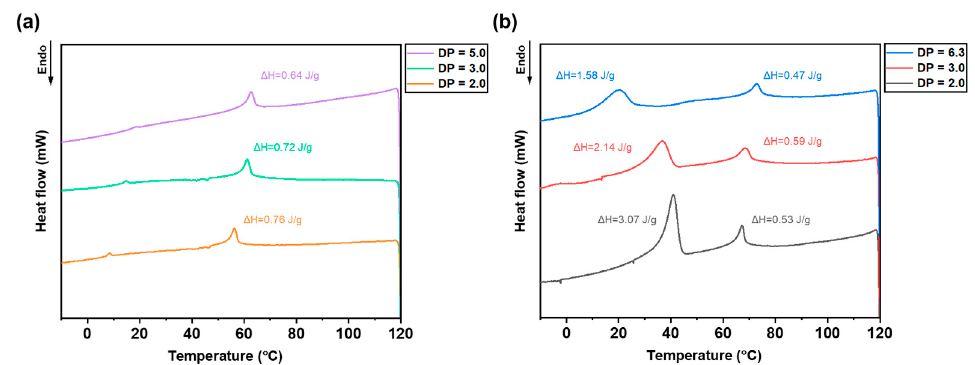
Figure 2. DSC thermograms of the oligomers with no acrylate end groups of various DPs containing ( a ) 0% smectic monomer and ( b ) 25% smectic monomer during the cooling cycle at a cooling rate of 5 °C /min.